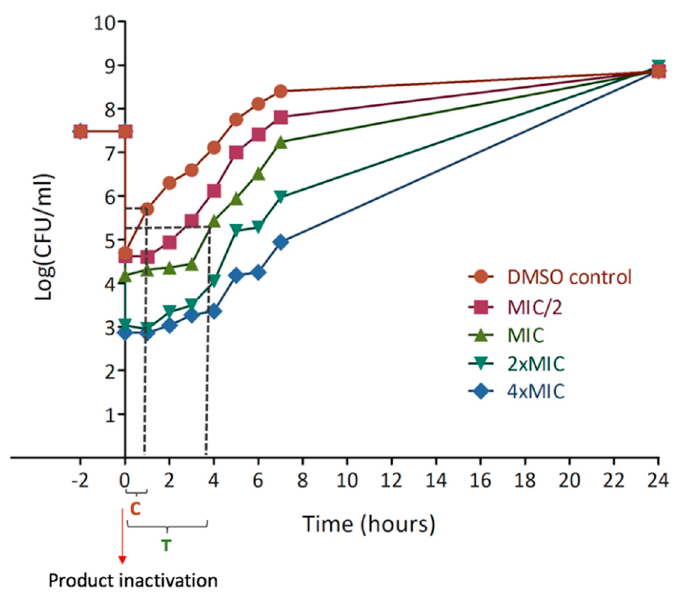
Figure 6. Post-antibiotic curve of xanthohumol indicating graphical determination of parameters for the determination of the growth delay. Time between − 2 and 0 shows the pre-treatment with antibacterial product. Time 0 corresponds to the product inactivation. The growth retardation is quantified during the first hours of culture, comparing each condition with the control, using the formula: PAE = T − C. Where T is the time needed for the bacterial population to grow by 1 log10 (the present example is for the MIC) and C is the corresponding time for the control.